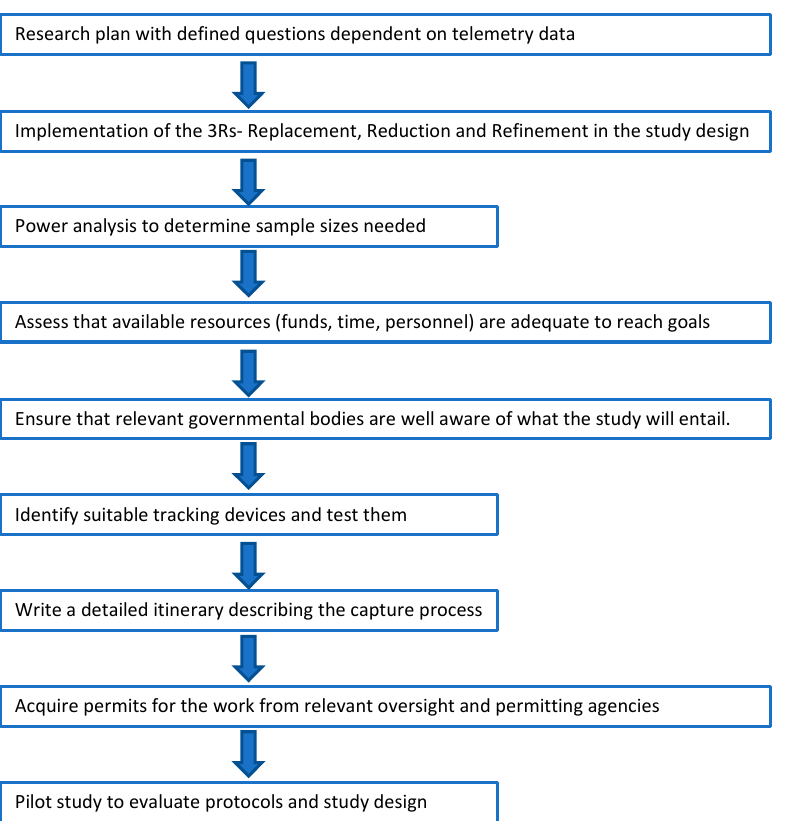
Figure 1. Flowchart summarizing the main steps needed to launch a telemetry study.